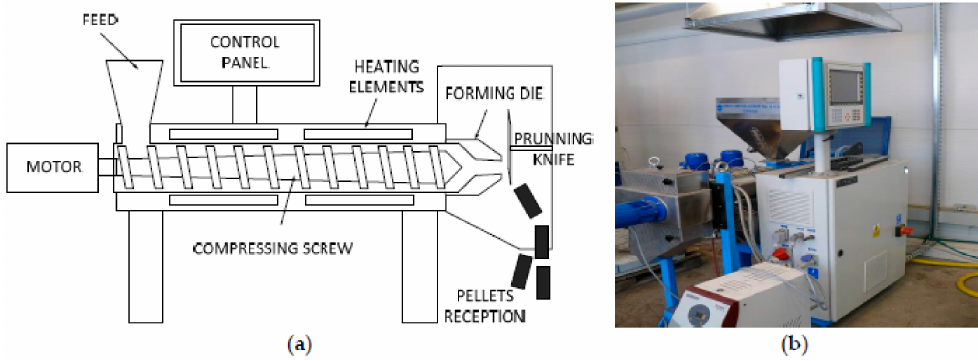
Figure 3. ( a ) Scheme of single screw extruder; ( b ) overview of single screw extruder